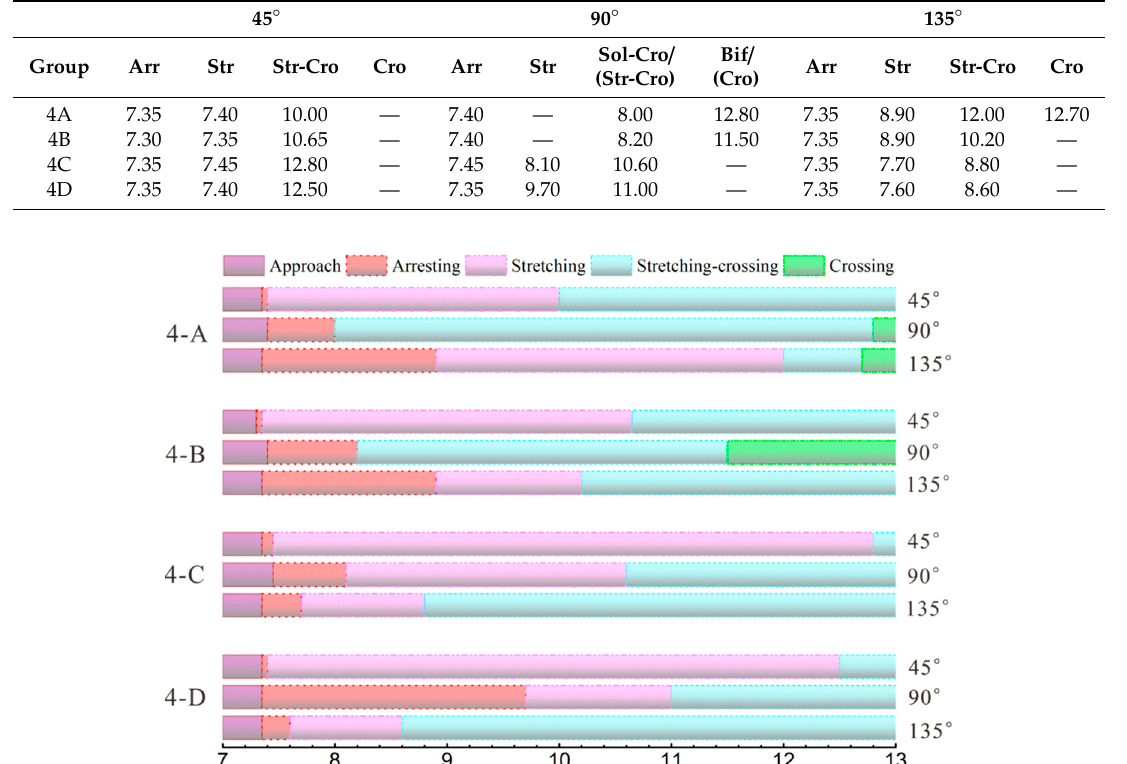
Table 9. Fluid pressure values corresponding to di ff erent WP elastic modulus values.